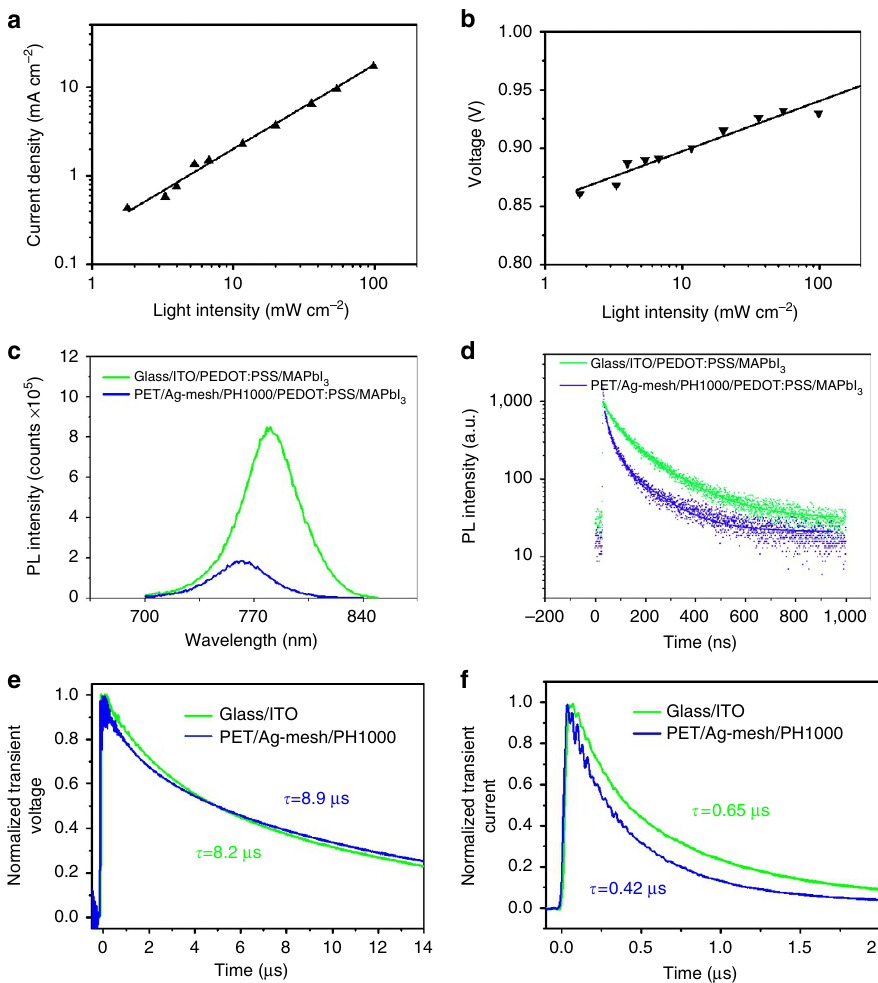
Figure 4 | Characterization of flexible pero-SCs. ( a ) J SC as a function of light intensity in a double log plot. ( b ) V OC as a function of light intensity in a semi-log scale. ( c ) The steady-state PL spectra of perovskite film on various substrates, and ( d ) TRPL decay transient spectra of PET/Ag-mesh/PH1000/ PEDOT:PSS/MAPbI 3 and glass/ITO/PEDOT:PSS/MAPbI 3 . Charge transient time and traces for optimized devices based on glass/ITO and PET/Ag-mesh/ PH1000 electrodes by ( e ) transient photovoltage measurement under 0.5 sun bias light and ( f ) transient photocurrent measurement. NATURE COMMUNICATIONS|7:10214|DOI: